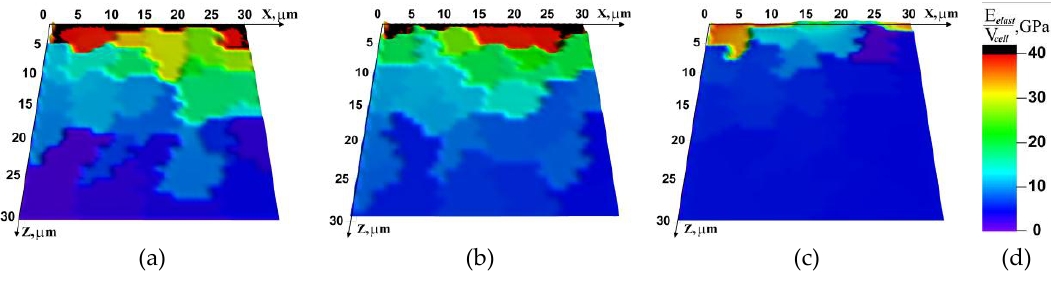
Figure 5. Specific elastic energy distribution on specimen faces at different temperatures at 500 μs after the beginning of loading. ( a ) −60 °C; ( b ) −20 °C; ( c ) 20 °C; ( d ) color legend.